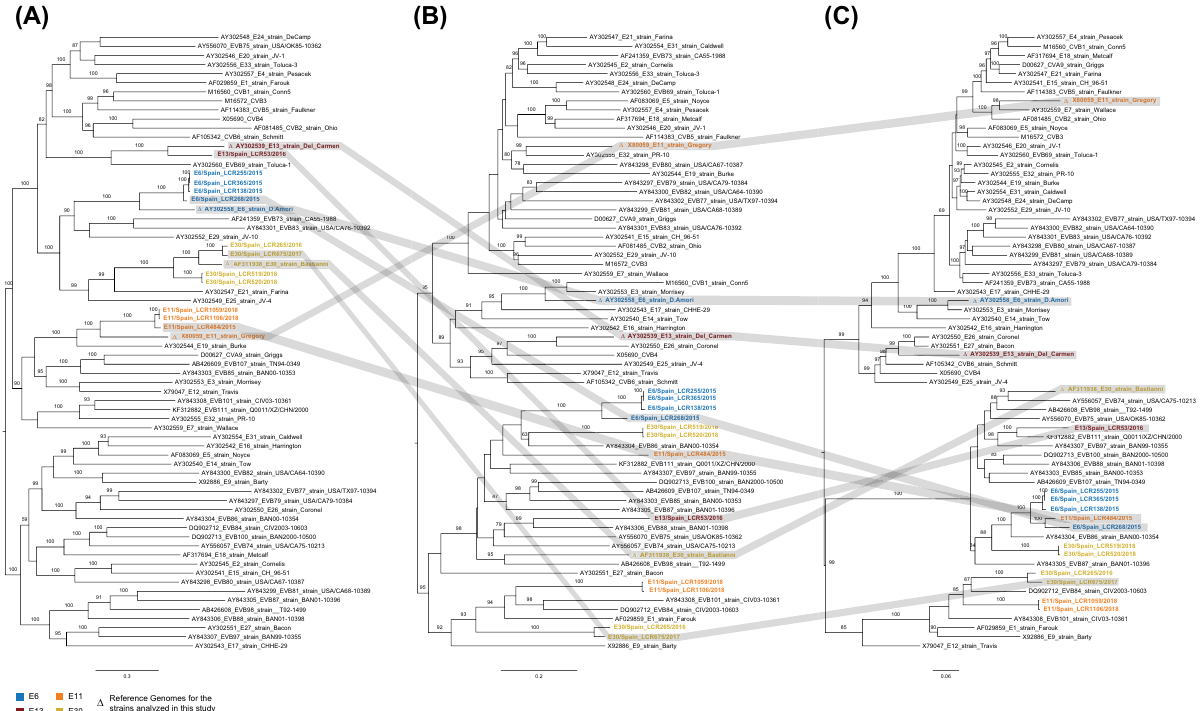
Figure 2. Phylogenetic analysis based on the P1, P2 and P3 coding sequences of the 12 study strains and other fully sequenced EV-B global strains. Maximum-likelihood phylogenetic trees were inferred using IQ-TREE2 on an alignment of ~ 2565, 1734 and 2268 nt sequences corresponding to the P1 ( A ), P2 ( B ), and P3 ( C ) coding regions respectively. The numbers at the nodes indicate bootstrap support values > 80 for that node. Scale bar represents nucleotide substitutions per site. GenBank accession numbers for published sequences are shown in the